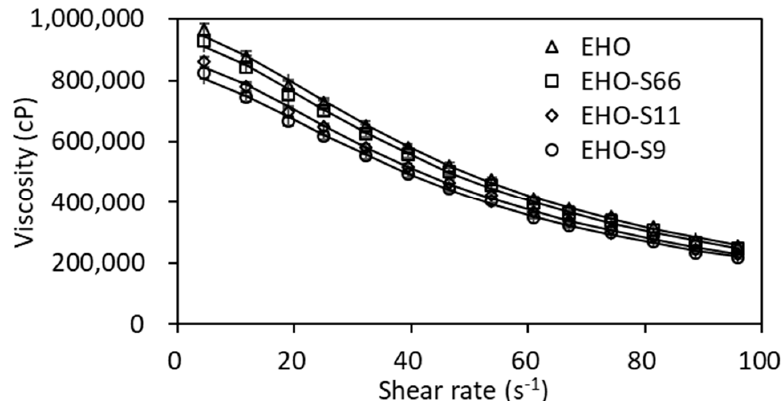
Figure 4. Rheological behavior of an extra-heavy oil (EHO) in the absence and presence of 1000 mg · L − 1 of SiO 2 nanoparticles with different mean particle sizes of 9 (S9), 11 (S11), and 66 nm (S66) at 30 ◦ C. The symbols are experimental data, and the continuous lines are from the Cross model.